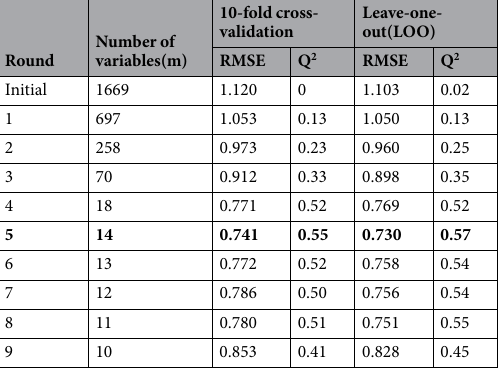
Table 1. The variable